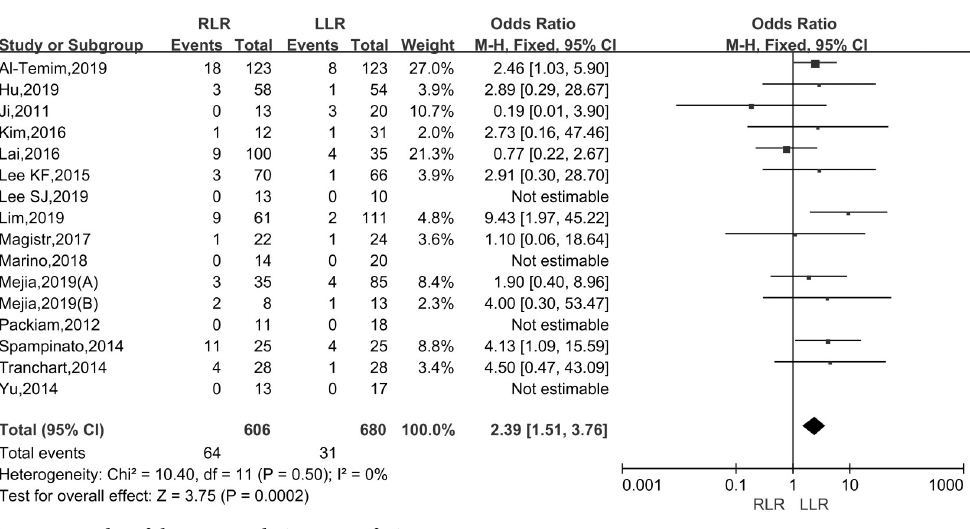
Fig 4. Forest plot of the meta-analysis on transfusion